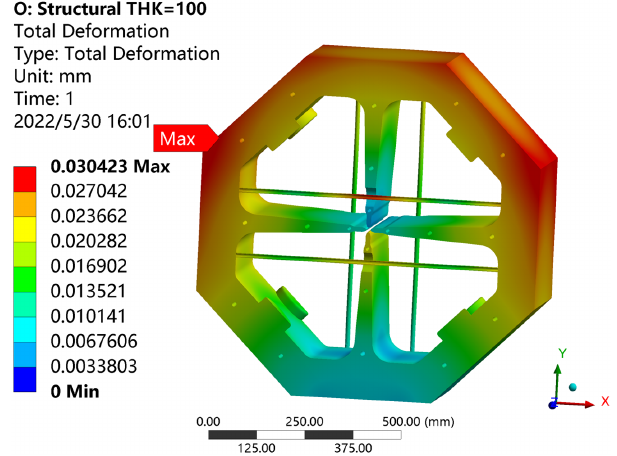
27. Deformation distribution of RFQ cavity with a wall thickness of 100